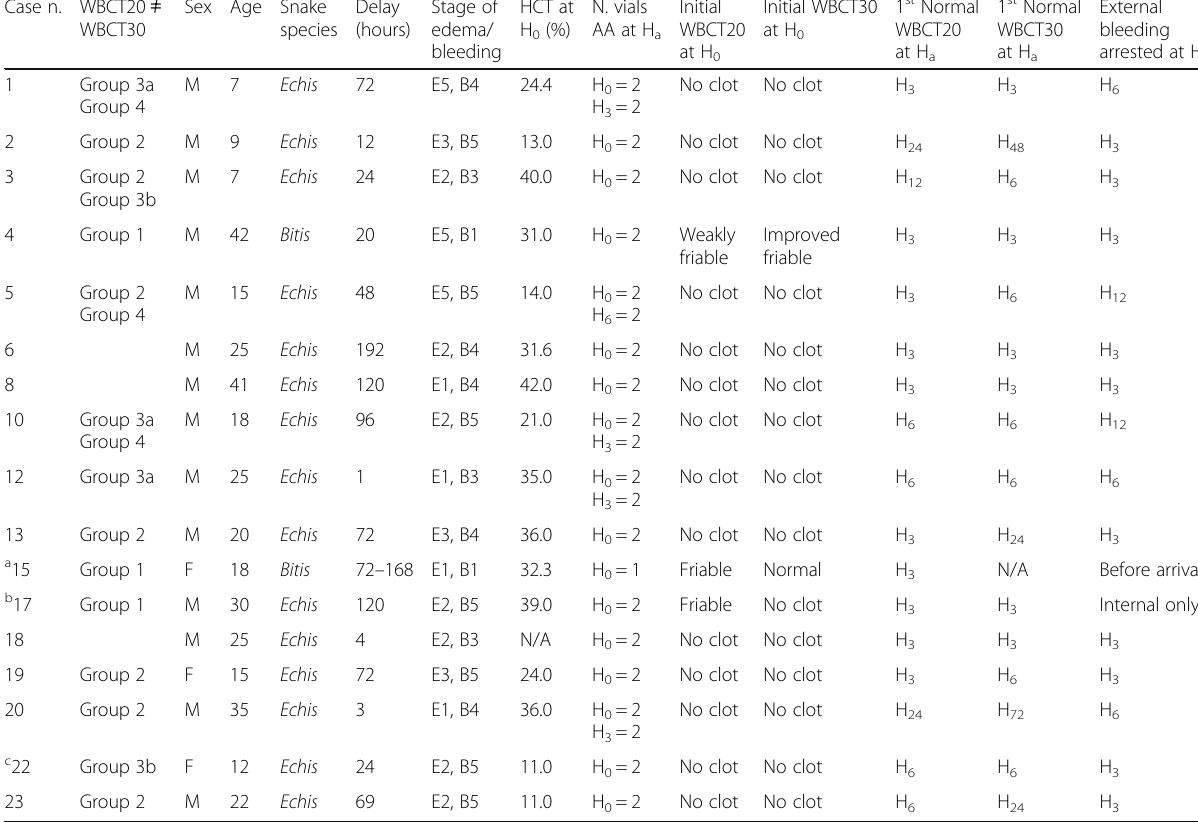
Table 3 Description, characteristics, and response to initial antivenom therapy in 17 patients with abnormal WBCT results Case n. WBCT20 ≠